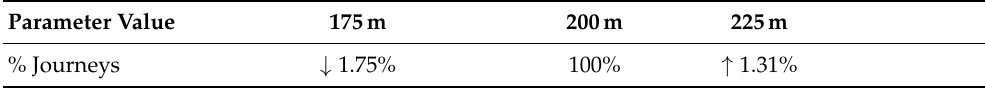
Table 3. Sensitivity Analysis of the Distance Threshold δ D . Parameter Value 175m 200m